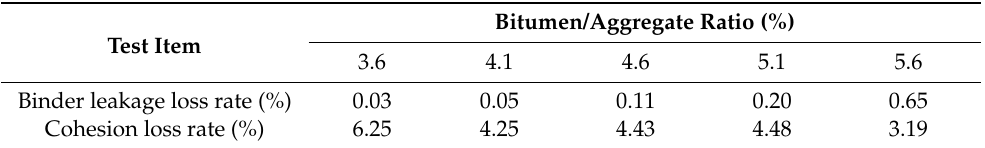
Table 10. Test results of binder drainage test and Cantabro test.